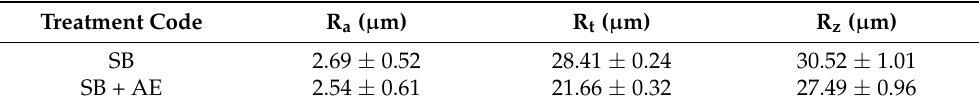
Table 2. Roughness measurements for the two dental implants studied. No statistically significant differences were observed in any roughness parameter.